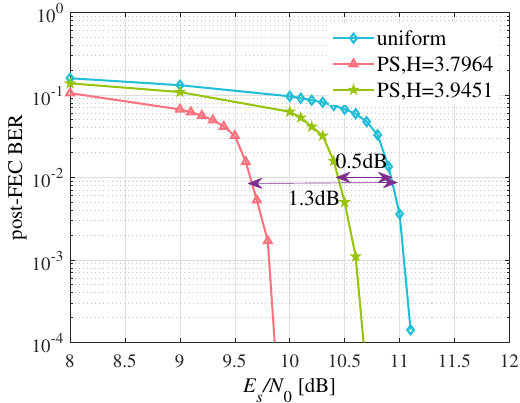
Figure 7. Post-FEC BER versus E s / N 0 with or without the